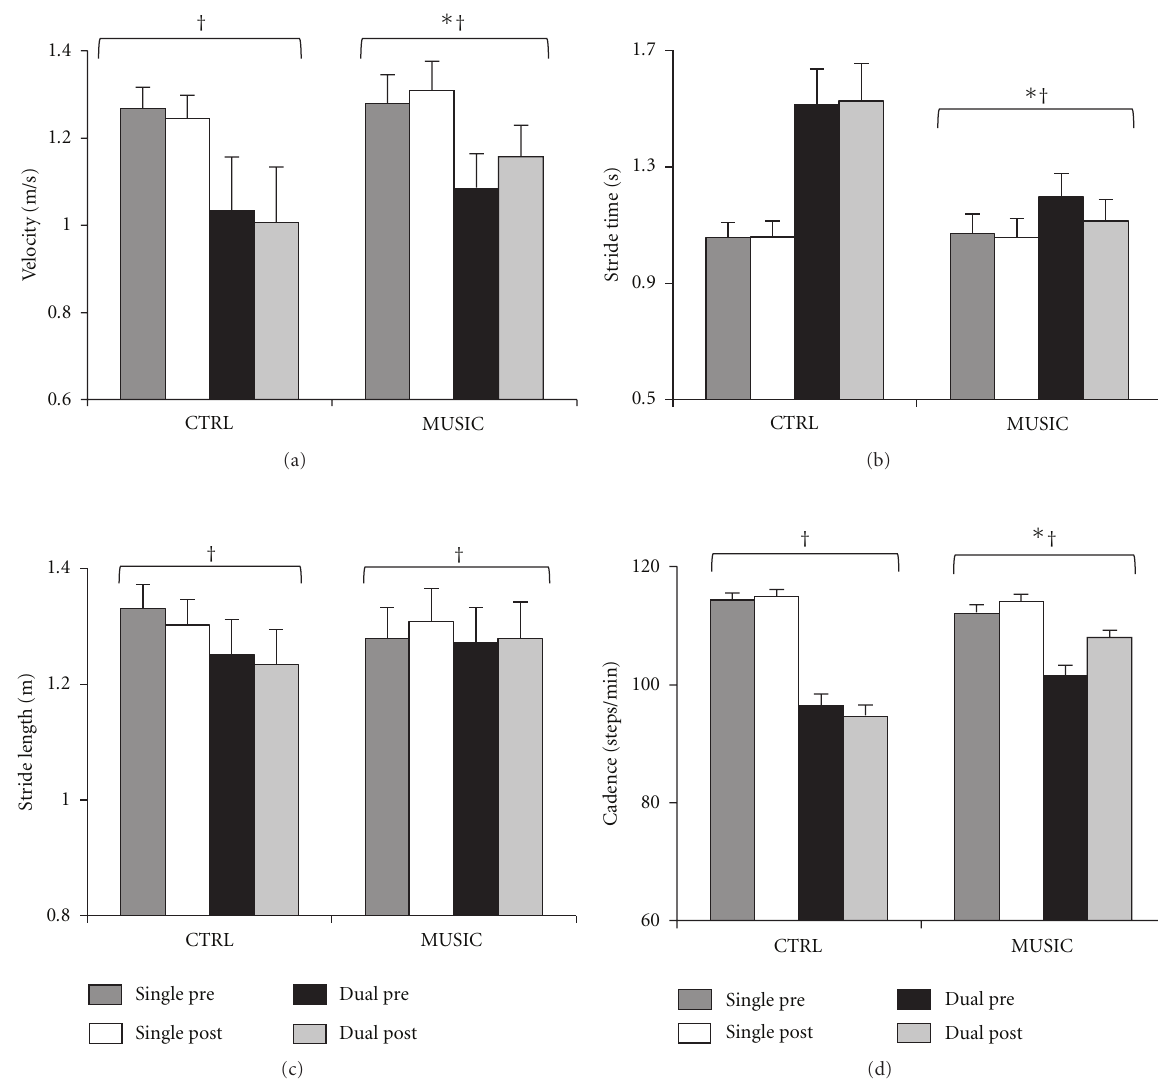
Figure 3: E ff ect of intervention on gait parameters in single and dual task conditions. E ff ect of intervention on (a) velocity, (b) stride time, (c) stride length, and (d) cadence during single task and dual task conditions, pre- and post-intervention amongst CTRL and MUSIC groups (means and standard errors). ∗ Significant e ff ect of Time. † Significant e ff ect of Task.